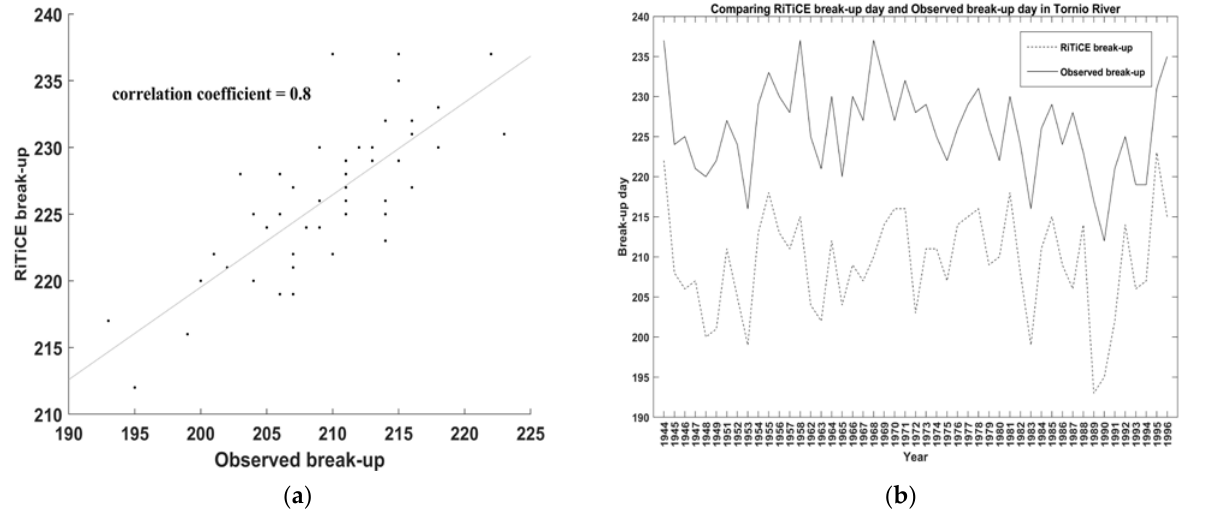
Figure 9. ( a ) Strong positive correlation between calculated BUDs by the RiTiCE and observed BUDs in Tornio River; ( b ) Comparison of calculated vs observed BUDs.